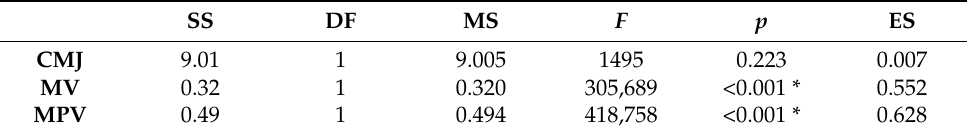
Table 1. Results of the repeated measures ANOVA for intra-subjects factor (pre vs. post).